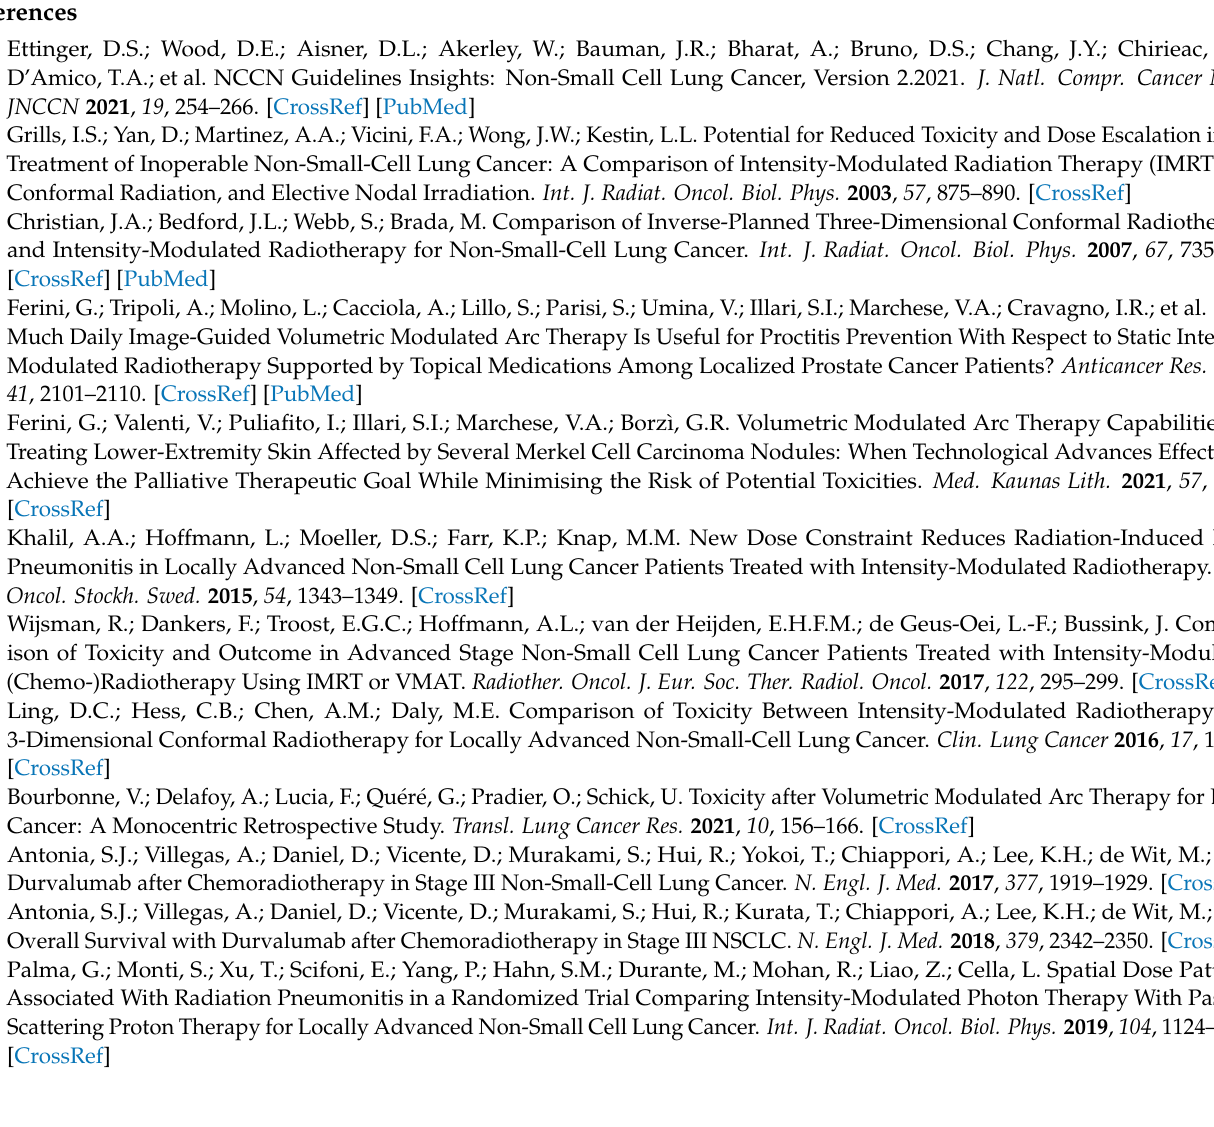
relation between the DICEPTV-Pmap and the success of the dosimetric optimization—ROC curve; Supplementary Figure S3: Flowchart of the results regarding the APT risk